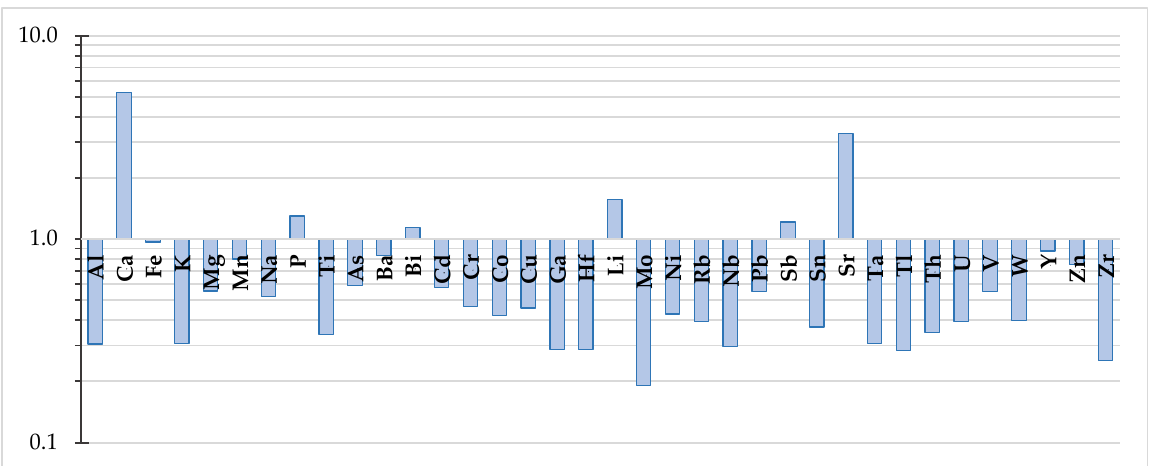
Figure 6. Ratio of concentration of elements in the sediment of Ob (our data) to the average concentration of elements in the sediment of the rivers of the Earth (for calculations, we used the data from [58]).